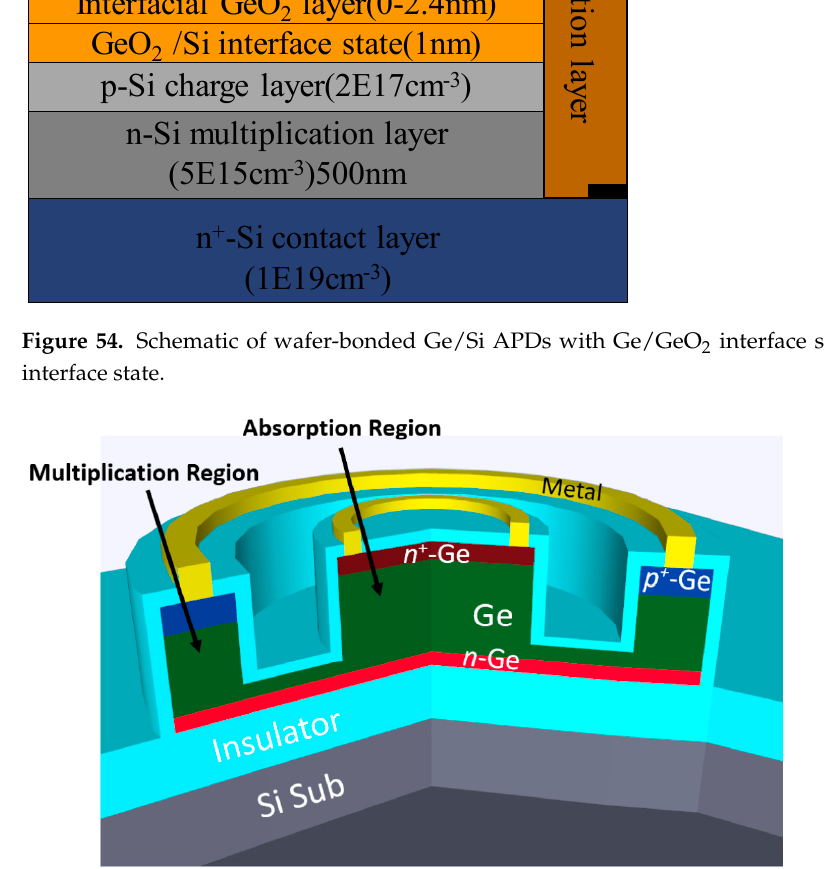
Figure 55. 3D Schematic of wafer-bonded Ge APDs on the GOI platform. Reproduced from [125], open access by NTU Library, 2021.